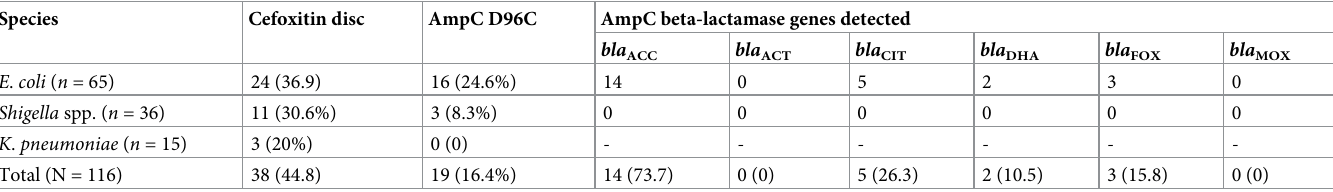
Table 4. Distribution of AmpC beta-lactamase producers and encoding genes among Enterobacteriaceae isolates. Species Cefoxitin disc AmpC D96C AmpC beta-lactamase genes